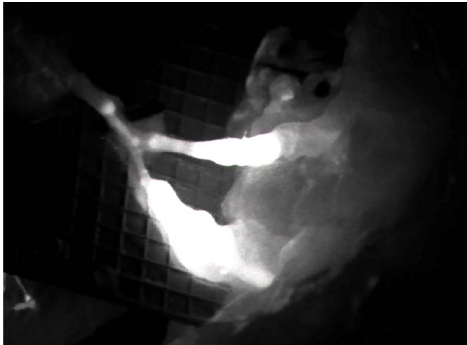
Figure 2. Intraoperative ICG imaging to check and confirm the patency and function of the